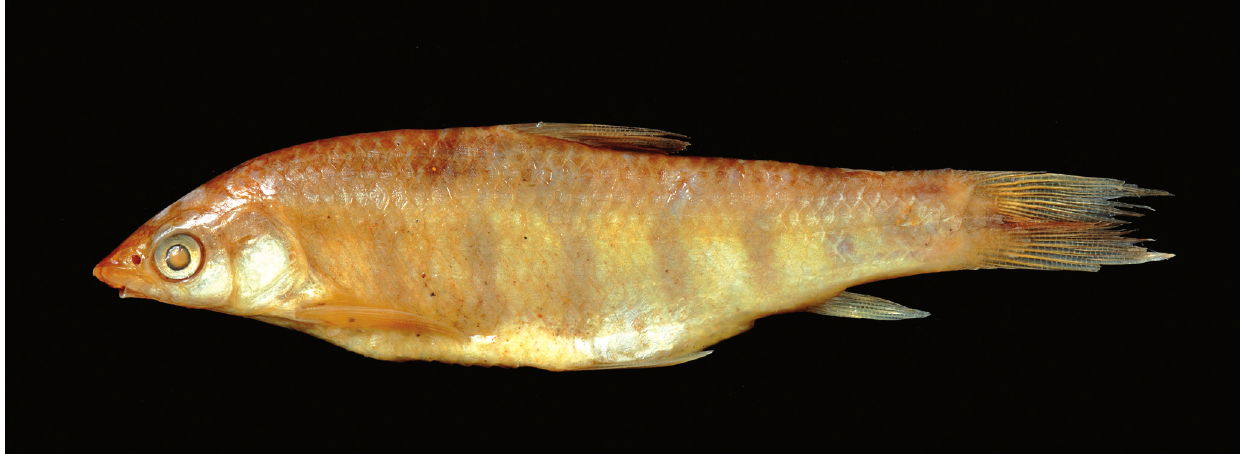
Fig. 7. Parodon caliensis , Lectotype, BMNH 1895.11.16.83, 57 mm SL, Colombia, Cali River, tributary of Cauca River (photo by James Maclaine,